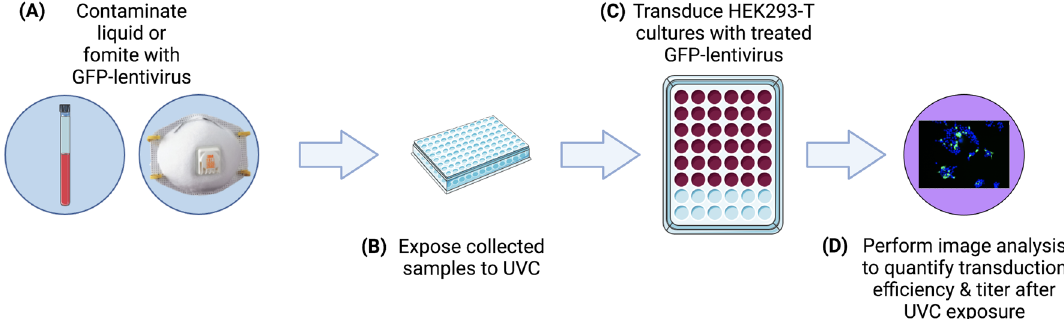
Figure 2. GFP-lentivirus experimental workflow. ( A ) Lentiviral samples are prepared either as a liquid medium or fomite. ( B ) A small representative portion of the sample is placed in a polystyrene 96-well plate and exposed to UVC light. ( C ) Treated samples are used to infect HEK293-T cells and incubated for two days. ( D ) A nuclear stain is added to facilitate cell counting using a high-content imaging device to determine a log reduction in virus infectivity after UVC irradiation.